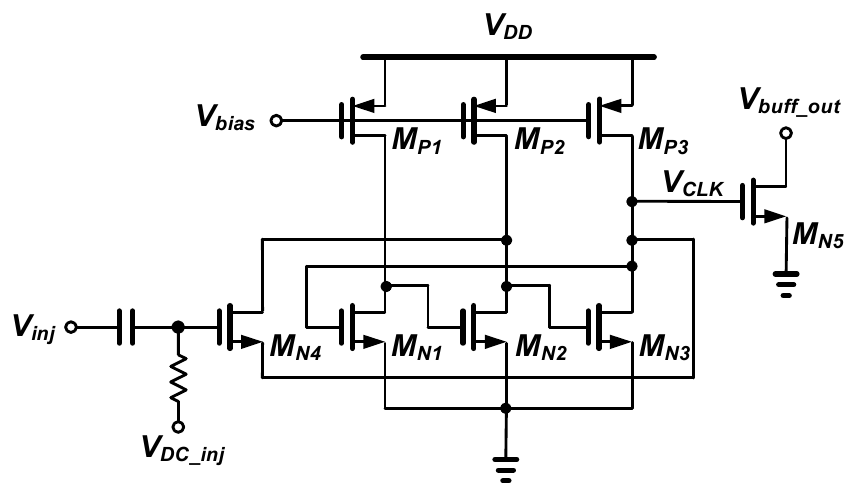
Figure 2. Schematic of the injection-locked RF clock harvester. The locking range is proportional to the width of the injection transistor M N4 and inversely proportional to the total capacitance of the injection node [40]. α inj V inj ≈ locking range (1) max C inj where α inj is an injection factor proportional to the width and gate bias voltage of the injection transistor M N4 . V inj is the magnitude of the RF injection voltage and C inj is the total capacitance of the injection node. In order to enable locking operation even at low RF injection power, it is necessary to increase α inj without increasing V inj .